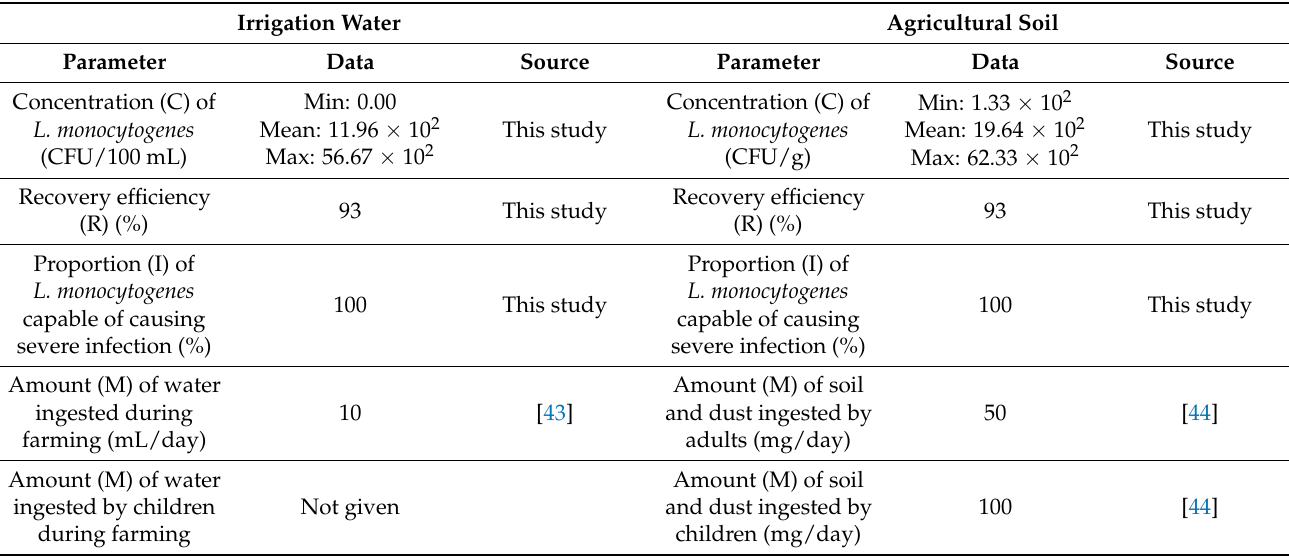
Table 2. Parameters inputted for exposure assessment in adults and